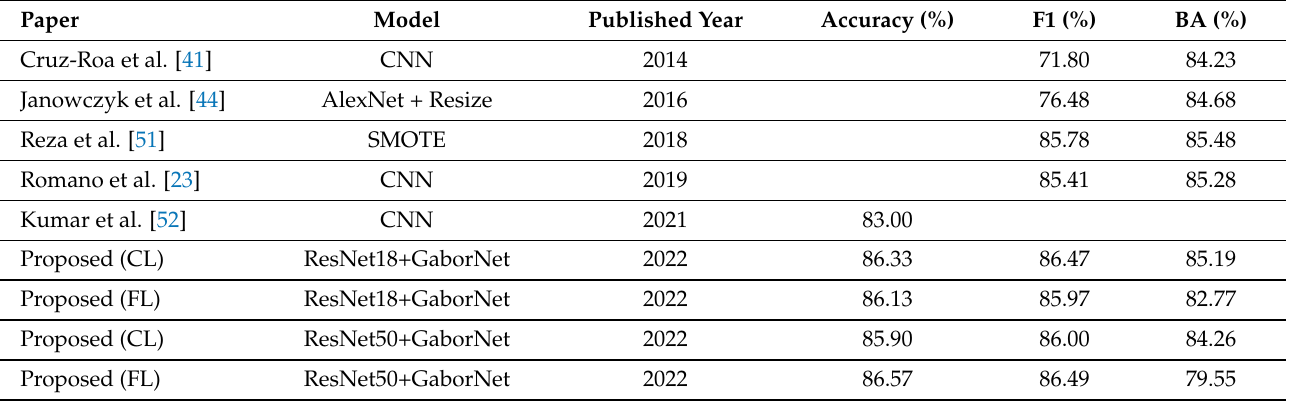
Table 5. Patch-wise comparison of our proposed models with studies from the literature on the BHI